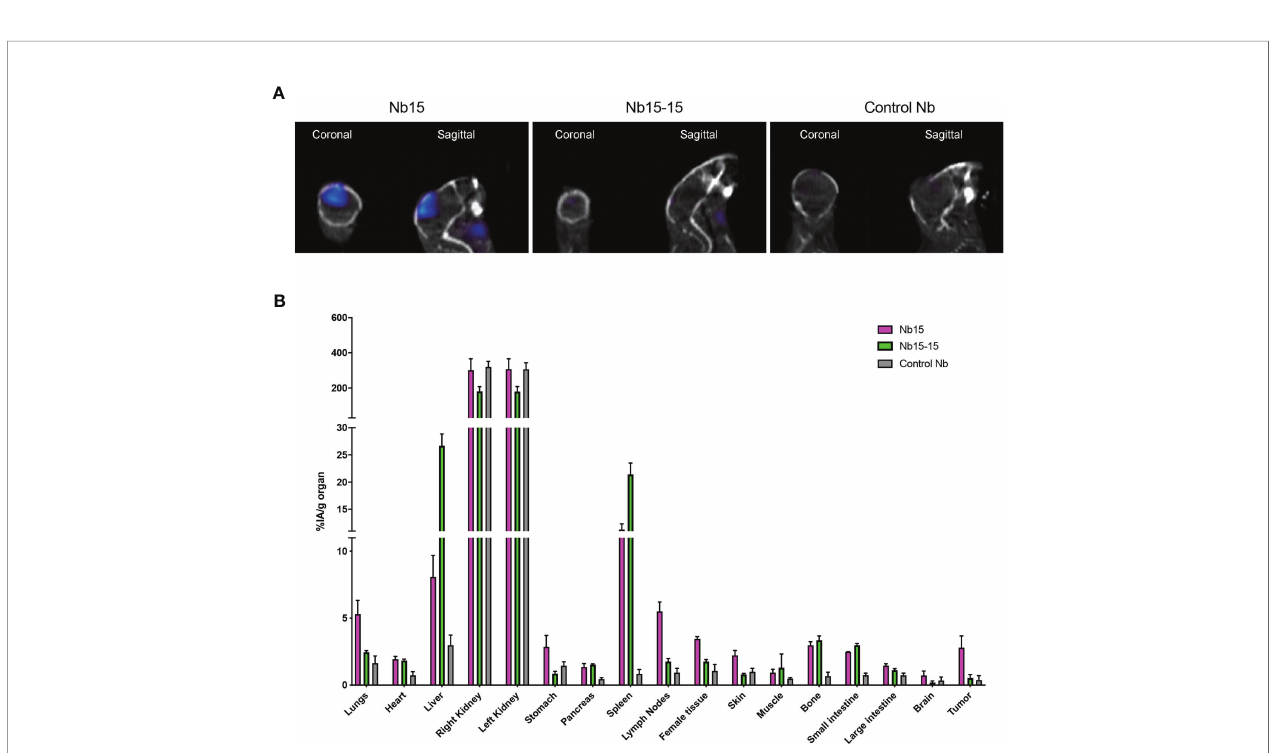
FIGURE 6 | Bivalent anti-SIRP a Nb15 exhibits impaired tumor targeting. (A) Fused pinhole SPECT/micro-CT images of GL261 tumor-bearing mice, inoculated with GL621 at the same time and randomized before injection of 99m Tc-labeled monovalent or bivalent anti-SIRP a Nb15 or a non-targeting control Nb R3B23. Mice were imaged 1 hour post tracer injection. Coronal and sagittal views are shown. Images are representative of n = 3 mice for each group. Similar results were obtained for the different mice in each group. (B) Ex vivo radioactivity values measured in the indicated dissected organs at 1 hour 45 min post injection with 99m Tc-labeled monovalent (magenta) or bivalent (green) anti-SIRP a Nb15 or non-targeting control Nb R3B23. Values are expressed as injected activity per gram (%IA/g). Results are represented as mean ± SEM of n = 3 mice for each